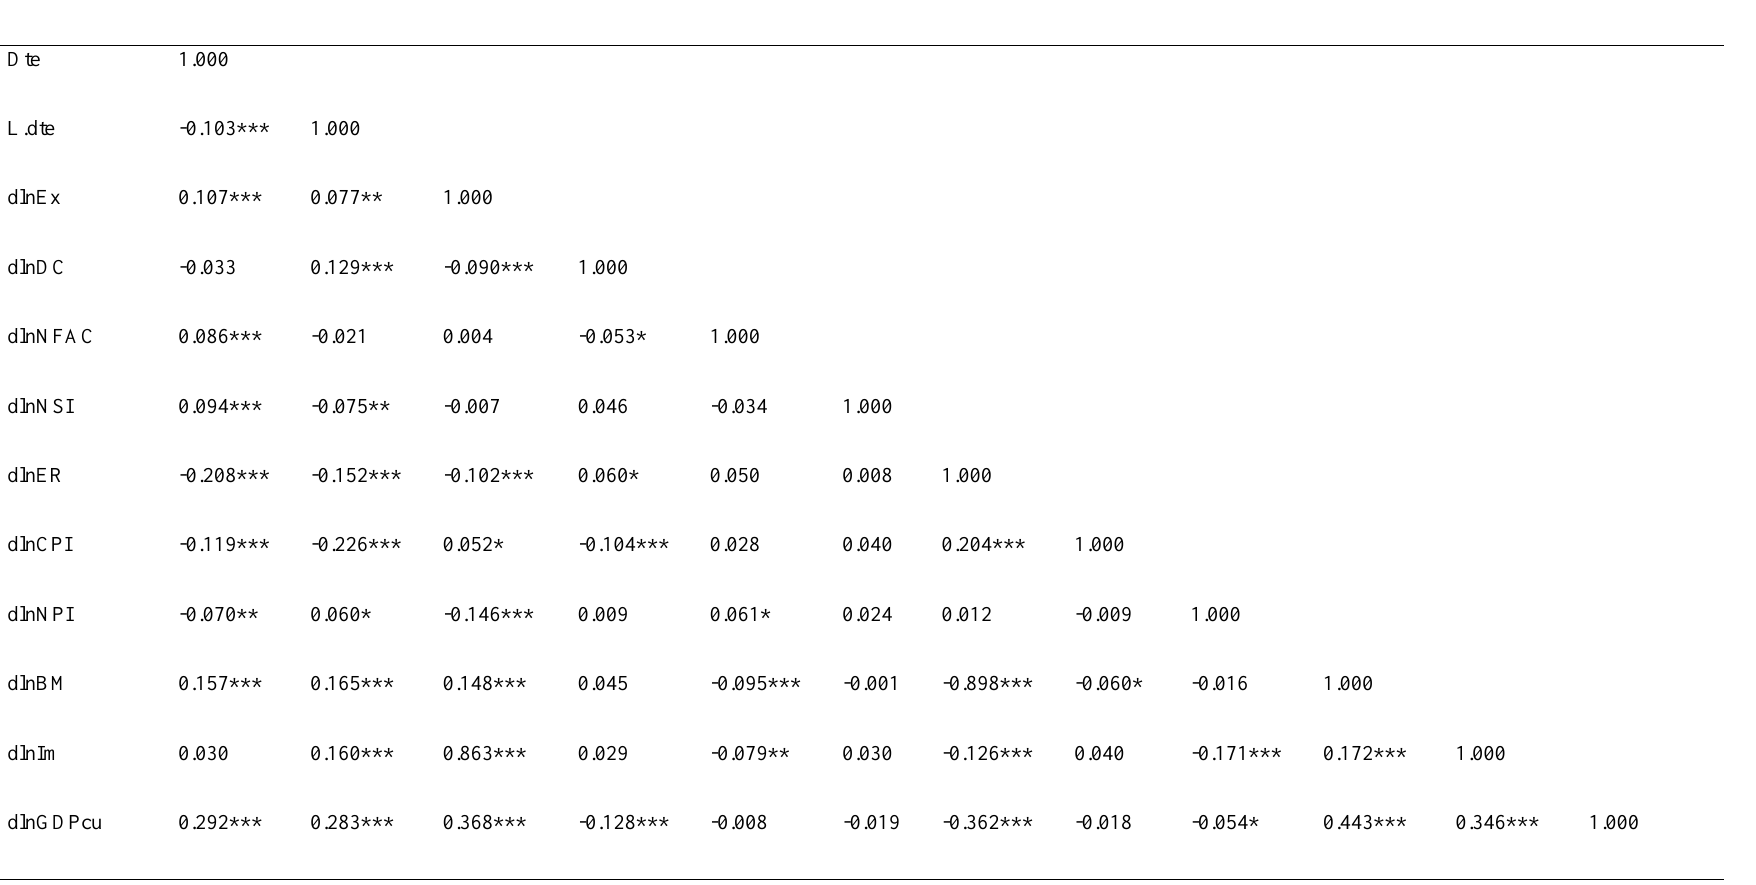
Table 9: Pairwise correlations matrix for Wealth Maximization with PRR covariate (significant variables with less than 90% correlation reported)